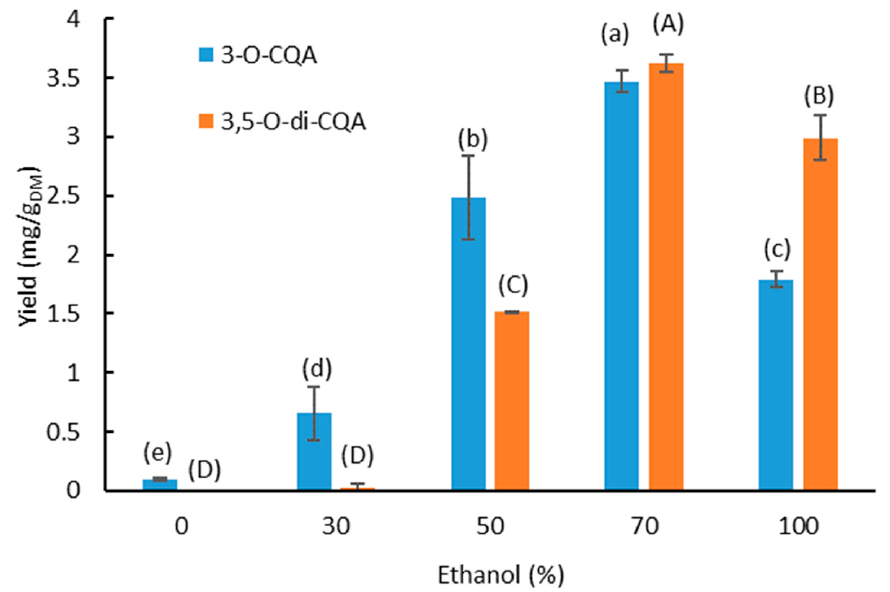
Figure 2. Effect of the percentage of ethanol in the extraction solvent on the extraction yield of 3- O -CQA and 3,5- O -di-CQA at (T = 30 ◦ C; S/L = 1/50; t = 24 h). Bars with different small letters indicate significant differences in the yield of 3- O -CQA ( p > 0.05) according to the Tukey test at 95%. Bars with different capital letters indicate significant differences in the yield of 3,5- O -di-CQA. The extraction yields of both compounds follow a parabolic trend, with optimal values (3.47 ± 0.01 mg/g DM and 3.62 ± 0.07 mg/g DM for 3- O -CQA and 3,5- O -di-CQA, respectively) at 70% ethanol. For ethanol percentages above 70%, the extraction yields decrease by 48.5% and 17.67% for the mono-and di-caffeoylquinic acids, respectively. The extraction of the two molecules is more efficient with the ethanol–water mixture than with the pure solvents at 30 ◦ C. Indeed, pure ethanol makes the extraction less efficient for both compounds (0 and 1.78 ± 0.01 mg/g DM for 3,5- O -di-CQA and 3- O - CQA, respectively), and the use of pure water appears to be completely inefficient for both compounds (<0.09 ± 0.01 mg/g DM ). The same results were found in the literature concerning the optimal percentage of ethanol to extract total phenolic compounds from chicory roots [8,39]. The mass transfer of phenolic compounds from the plant biomass into the liquid phase is controlled by their solubility in the extraction solvent. The solvent polarity has a major effect on this solubility. Thus, the selection of the solvents and their proportions, in the case of a mixture, is crucial for maximizing the transfer of the molecules from the matter towards the liquid phase. For further experiments, 70% ethanol was chosen.